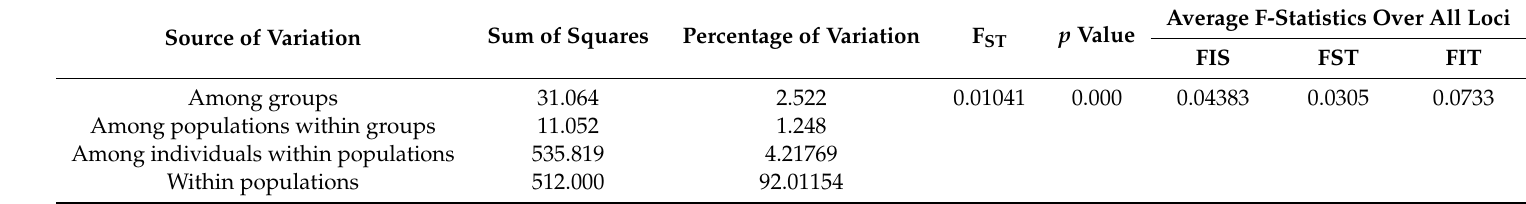
FIS—variance among individuals, FIT—variance within-individuals, and FS—variance among